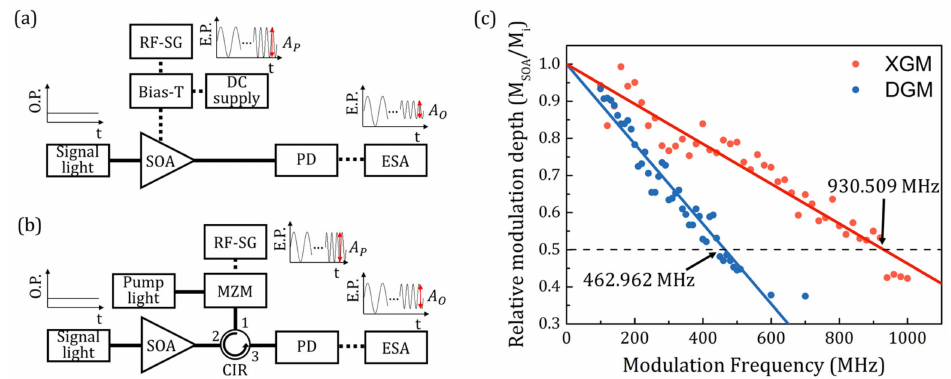
Figure 1. Experimental setup to measure the modulation depth of the semiconductor optical amplifier (SOA) (M SOA ) in ( a ) direct gain modulation (DGM) and ( b ) cross gain modulation (XGM). ( c ) Relative frequency response of the modulation depth of the SOA (M SOA / M i ) for both DGM and XGM.